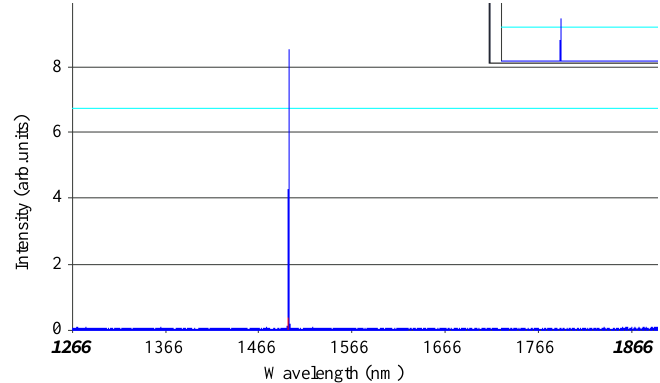
Figure 3. Signal wavelength of the MgO:PPLN OPO at temperature T = 120 °C for the grating period Λ = 29.5 μ m.